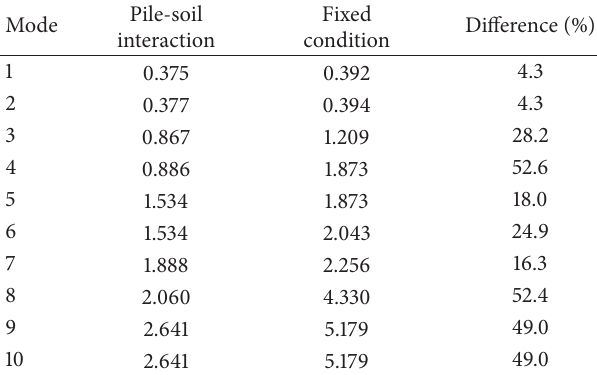
Table 11: Natural frequencies of hybrid substructure